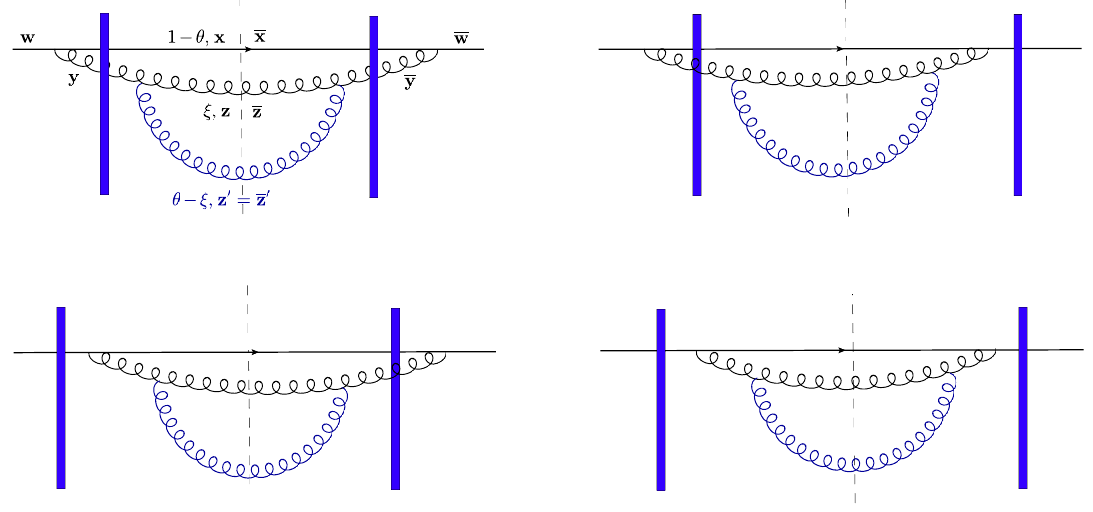
Figure 25 . The four graphs surviving in the collinear limit for the g → gg splitting (the unmeasured gluon is depicted in blue). These graphs are void of final-state